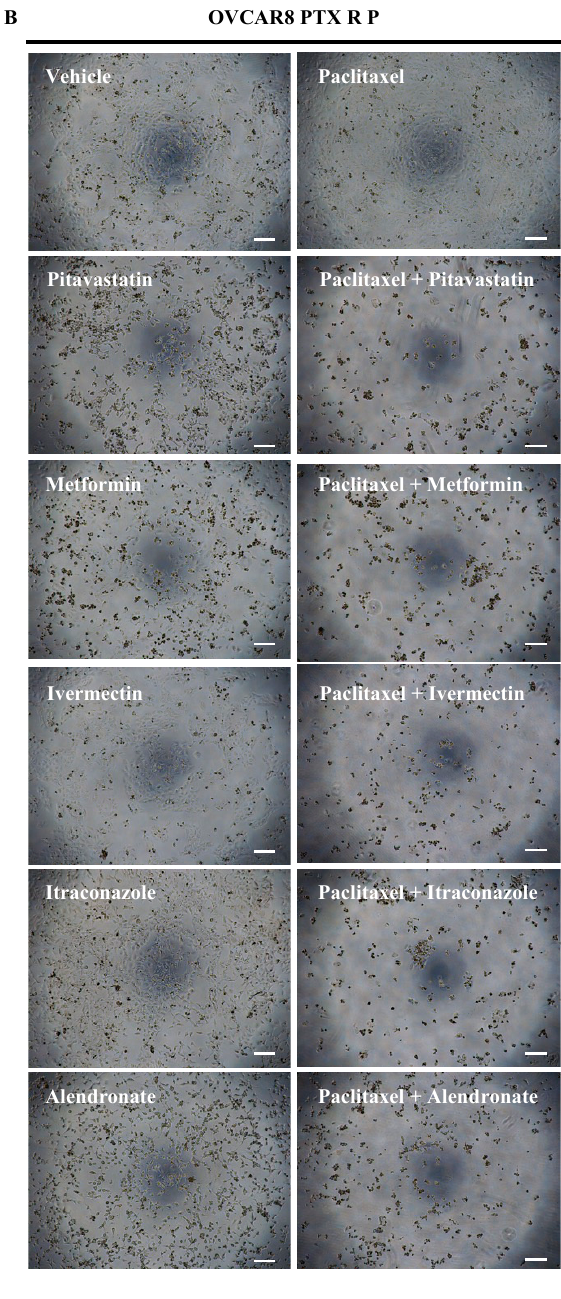
Figure 3. Representative microscopy images of ( A ) OVCAR8 and ( B ) OVCAR8 PTX R P cells after exposure to vehicle, Paclitaxel, Pitavastatin, Paclitaxel + Pitavastatin, Metformin, Paclitaxel + Metformin, Ivermectin, Paclitaxel + Ivermectin, Itraconazole, Paclitaxel + Itraconazole, Alendronate and Paclitaxel + Alendronate at concentration of IC 50 values of each drug for 48 h. All assays were performed in triplicate in at least three independent experiments. Scale bar, 200 μ m.